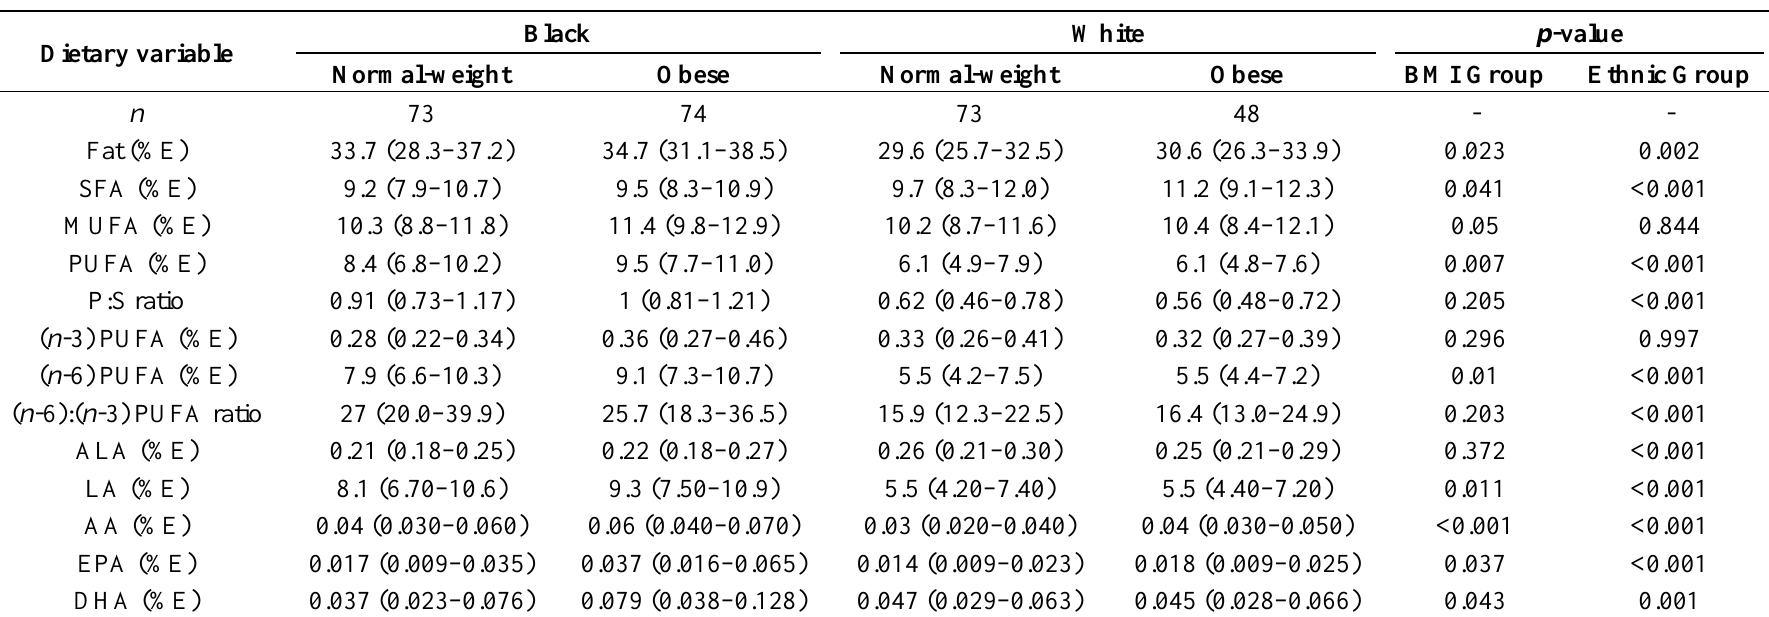
Table 3. Dietary intakes of normal-weight and obese adequate reporter black and white